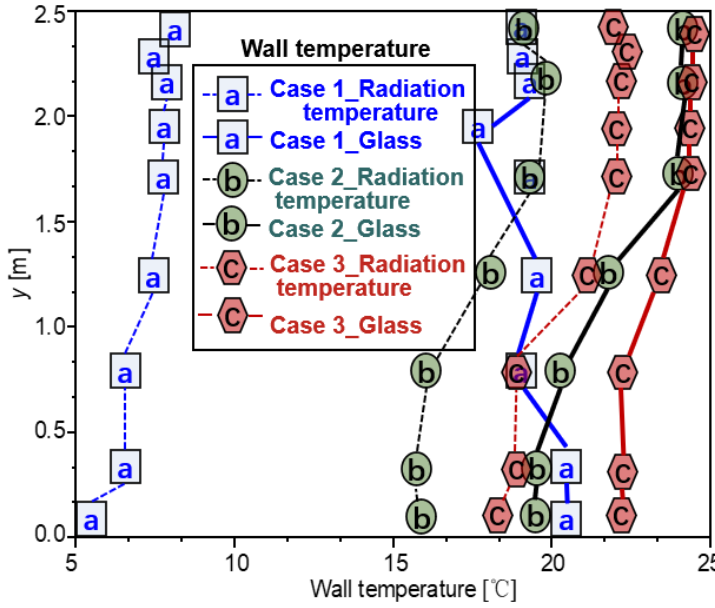
Figure 13. Distributions of glass wall temperature and indoor radiation temperature.